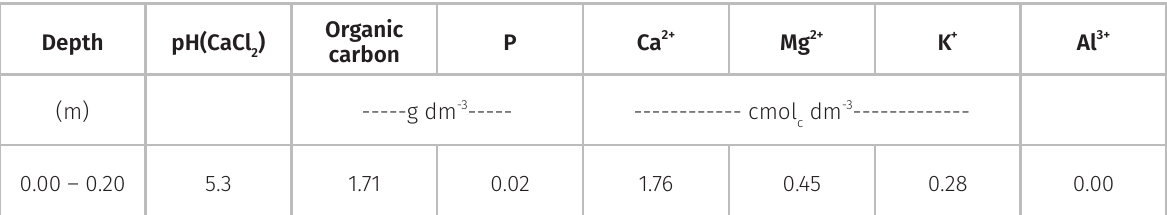
Table I. Soil chemical characterization.